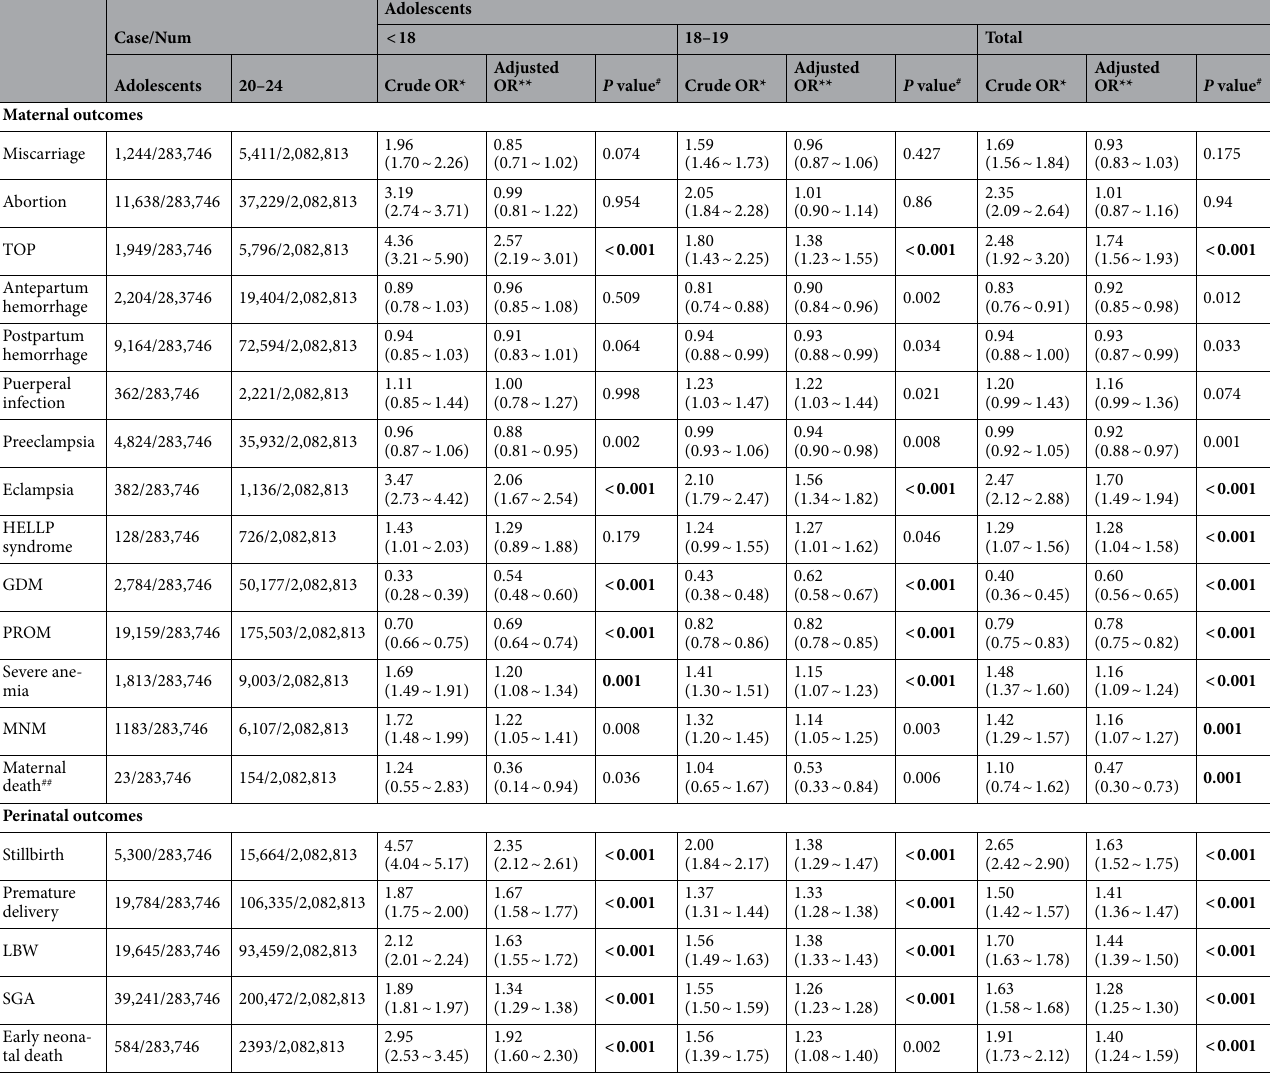
Table 3. Association between adolescent pregnancies and adverse maternal and perinatal outcome in China, 2012–2019. TOP terminate of pregnancy; TOP refers to induced labor at more than 28 weeks of gestation due to fetal or maternal causes. GDM gestational diabetes mellitus, PROM premature rupture of membranes, MNM maternal near miss, LBW low birth weight, SGA small-for-gestation-age. *Adjusted for clustering of births within hospitals. **Adjusted for clustering of births within hospitals, region, birth location (urban/rural), hospital level, year, and the mother’s education status, marital status, caesarean history and parity. # P value of the adjusted model. # # Maternal death refers to death during